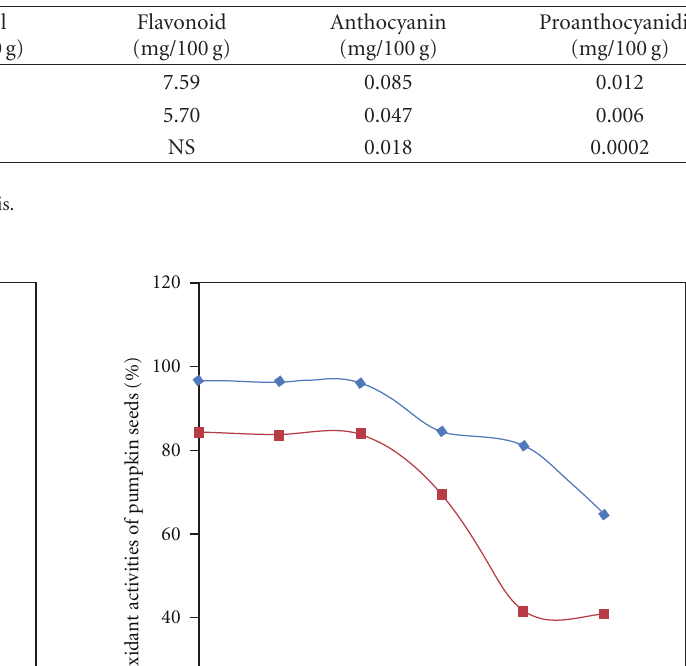
∗ : significant at 0.05 level of probability. ∗∗ Table 5: Antioxidant activities and its components in Pumpkin seeds as a ff ected by season.